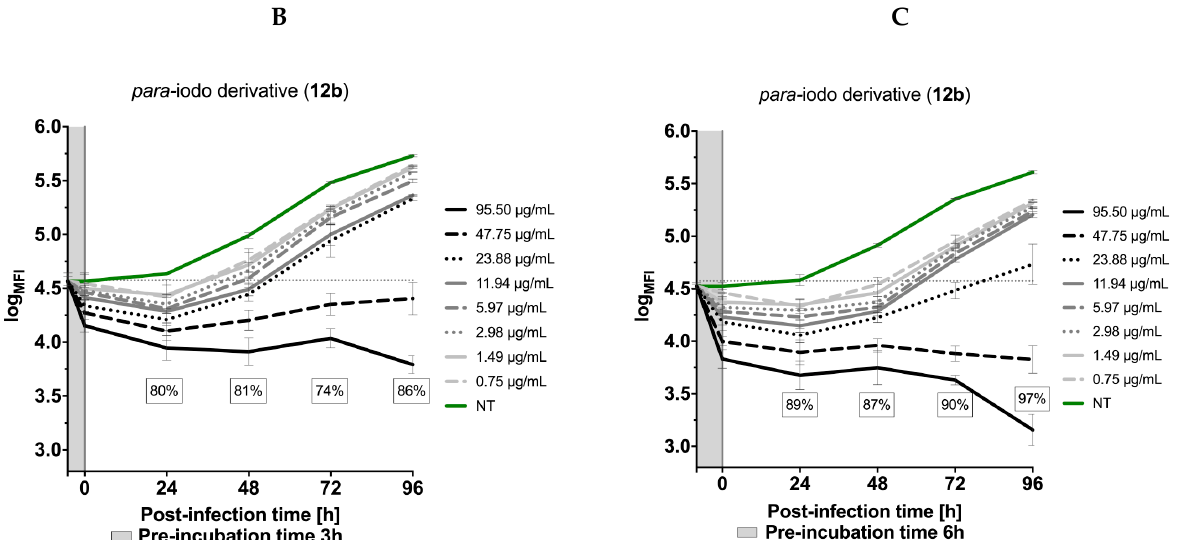
Figure 11. The kinetics of T. gondii growth. Concentration and time dependent curves of 1,3,4-thiadiazoles derivative 12b against T. gondii RH-GFP strain. ( A ) Tachyzoites were given 1 h to allow them to infect host cells in the absence of compound and then were exposed to 12b for 96 h at 37 ◦ C. Fluorescence measurement was performed every 24 h. ( B , C ) Tachyzoites were exposed to 12b for 3 and 6 h (pre-incubation time) at 37 ◦ C, then added to the Hs27 cells, incubated for 96 h at 37 ◦ C. Fluorescence measurement was performed every 24 h. Experiments were performed in triplicate, data presented as logarithm of mean fluorescence intensity (log MFI ). MFI—mean fluorescence intensity.